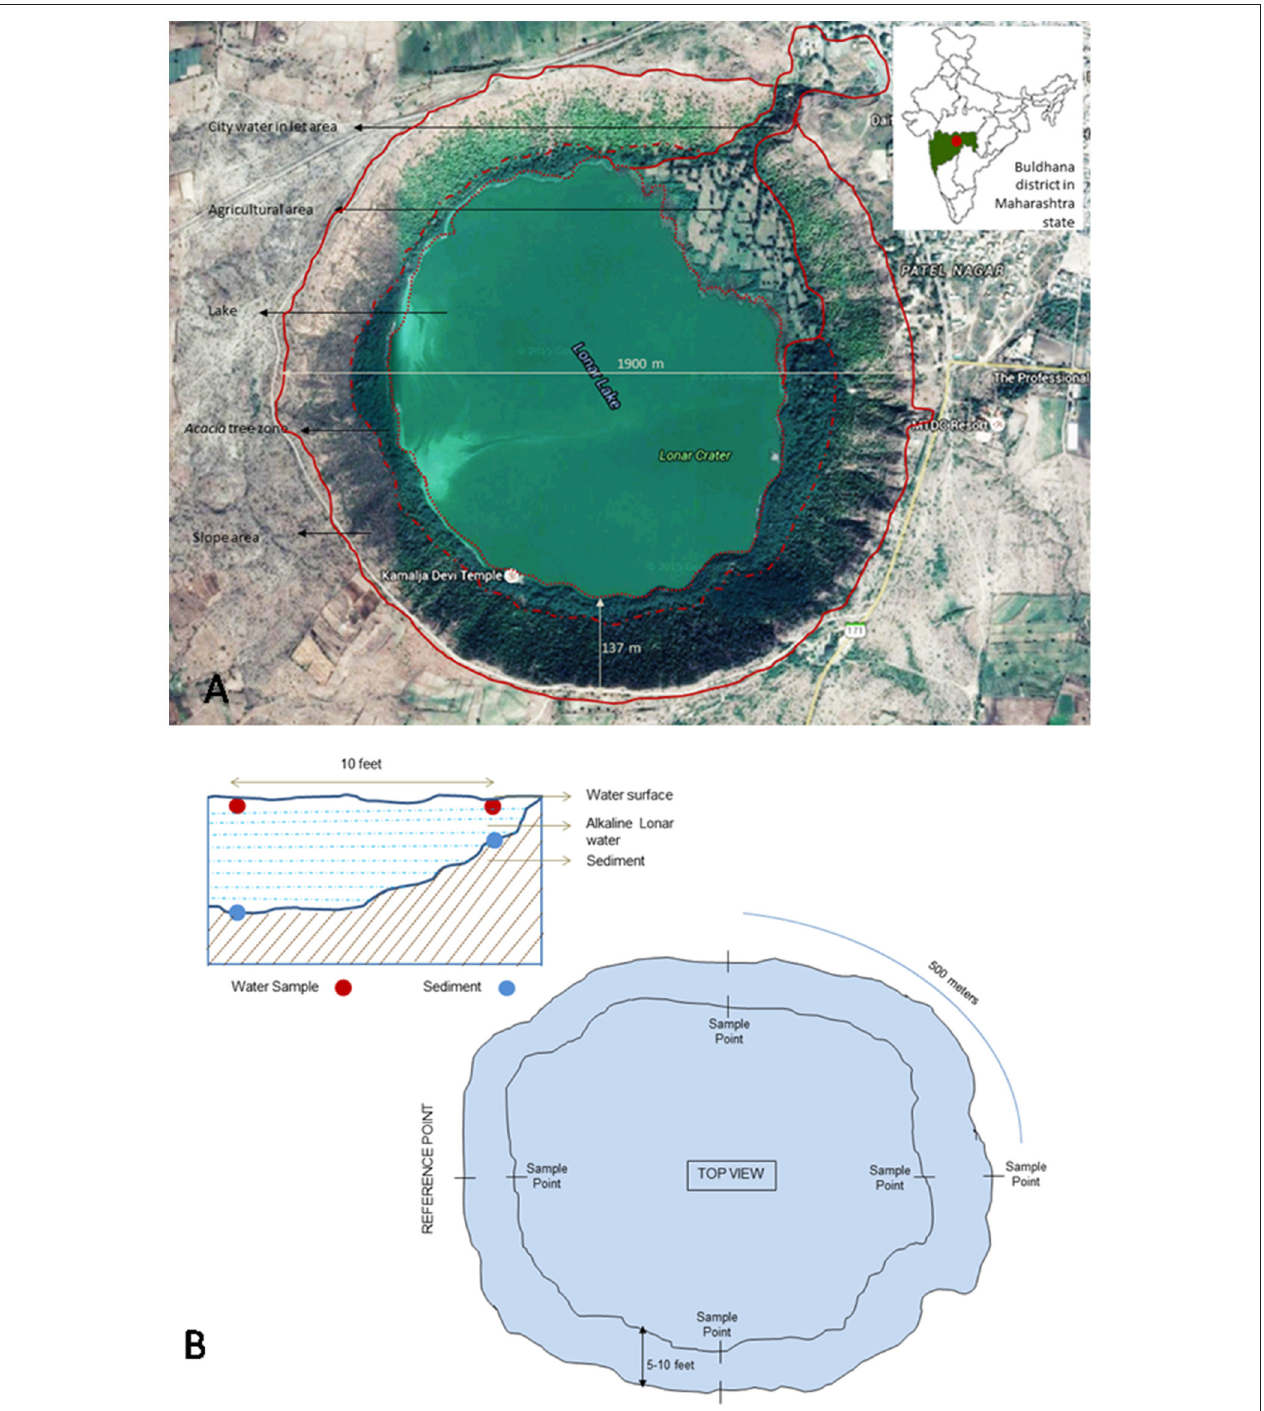
FIGURE 1 | (A) Google image of Lonar lake and its location on Indian map (modified from google maps) (Map data: Google, DigitalGlobe). (B) Schematic representation of lake and details of sampling strategy.